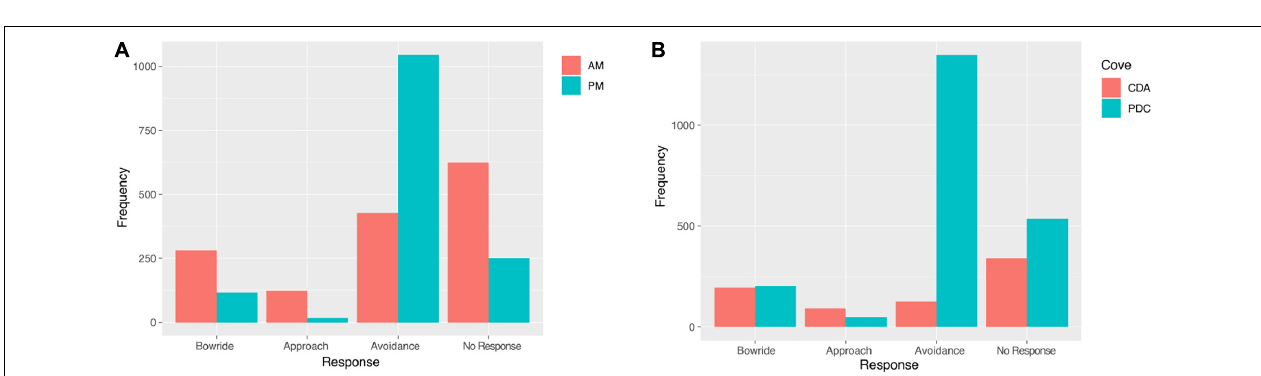
FIGURE 4 | Effect plot of the prediction model based on the data for the frequency of surface behavior and number of vessels present in each encounter with bottlenose dolphins, for the (A) Chañaral de Aceituno (CDA) and (B) Punta de Choros (PDC) coves.